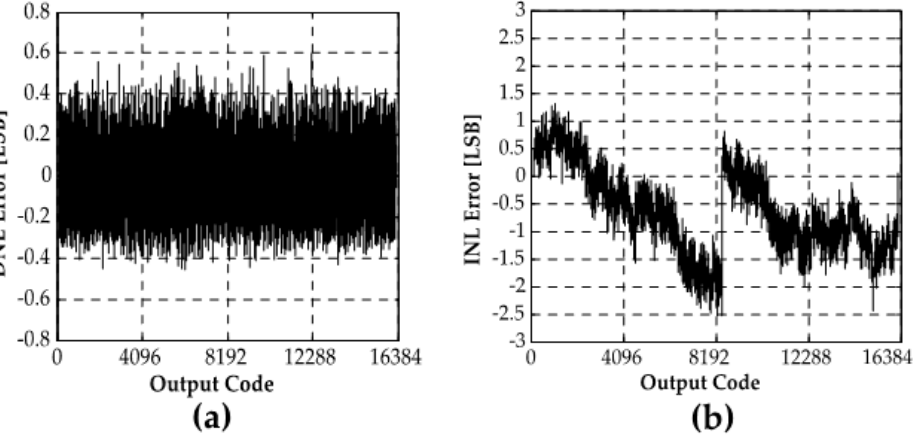
Figure 13. Measured ( a ) DNL error and ( b ) INL error. The DNL error and INL error is − 0.46/0.6 LSB and − 2.53/1.32 LSB, respectively. They are calculated from a histogram test with full-swing input and 16,384 sampling